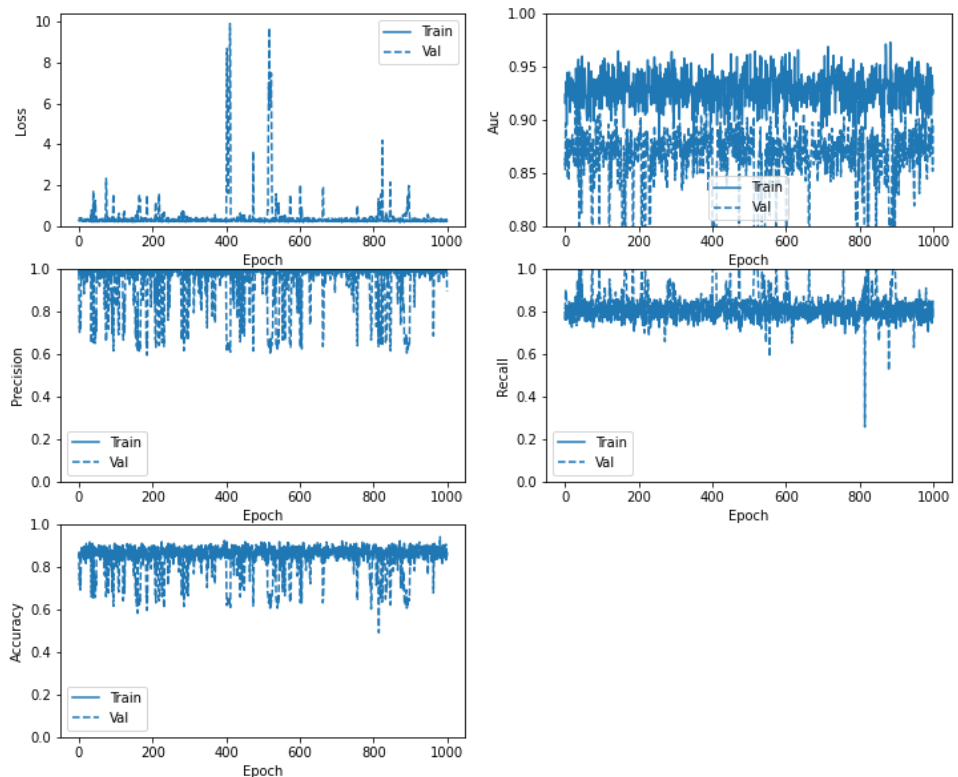
Figure 14. Loss, AUC, precision, recall, and accuracy between the training and validation phases, with the number of epochs for the IMG-CNN